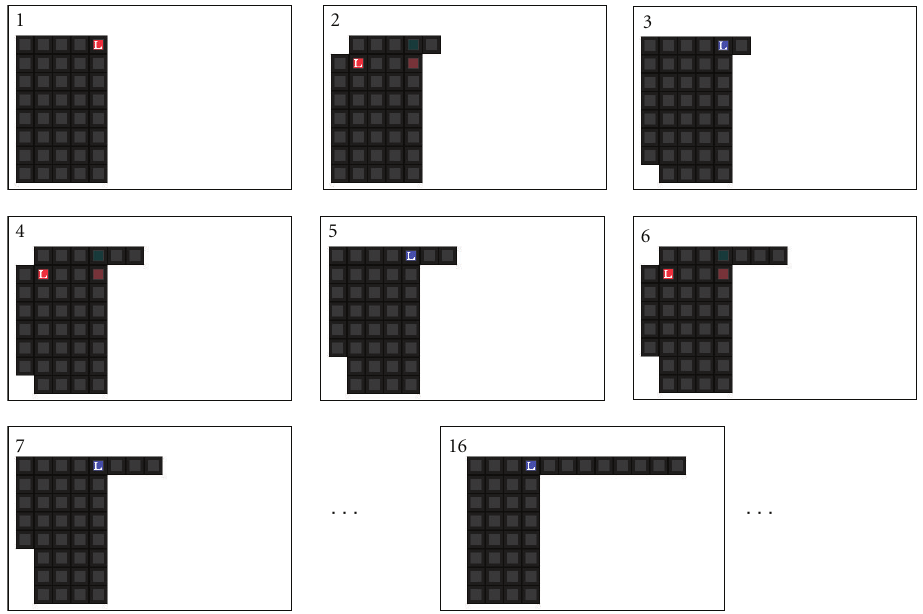
Figure 11: Simulation result of cantilever construction from 8 × 5 rectangle structure.